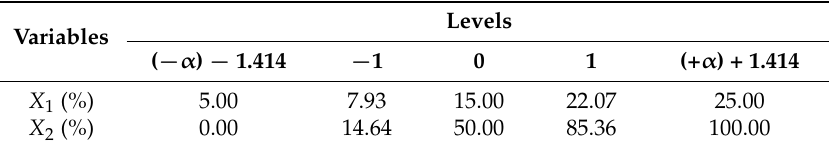
Table 2. Experiment design runs in DPS v14.50 (Data Processing System).